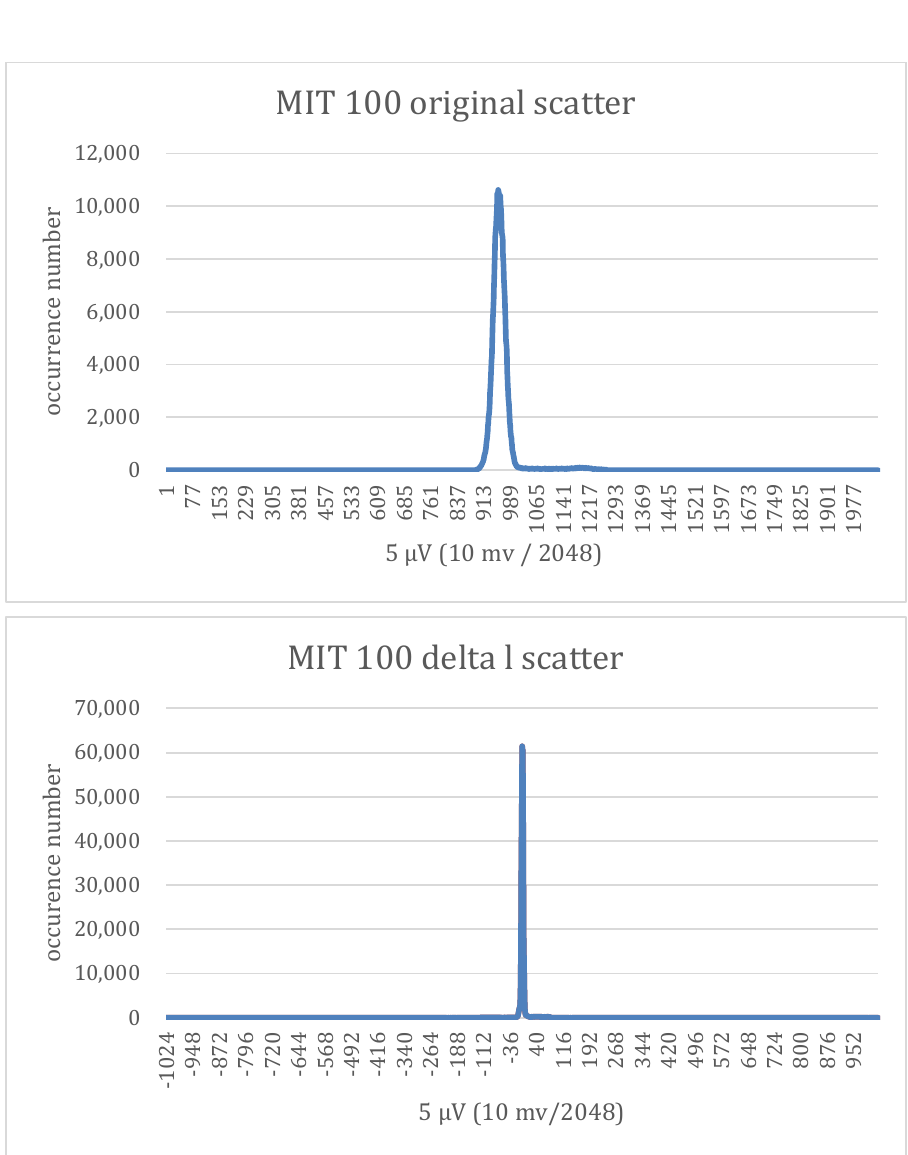
Figure 3. Comparison of probability of occurrence of each distinct symbol for an electrocardiogram (ECG) (original) volume and delta volume variance with MIT/BIH Arrhythmia Database 100.